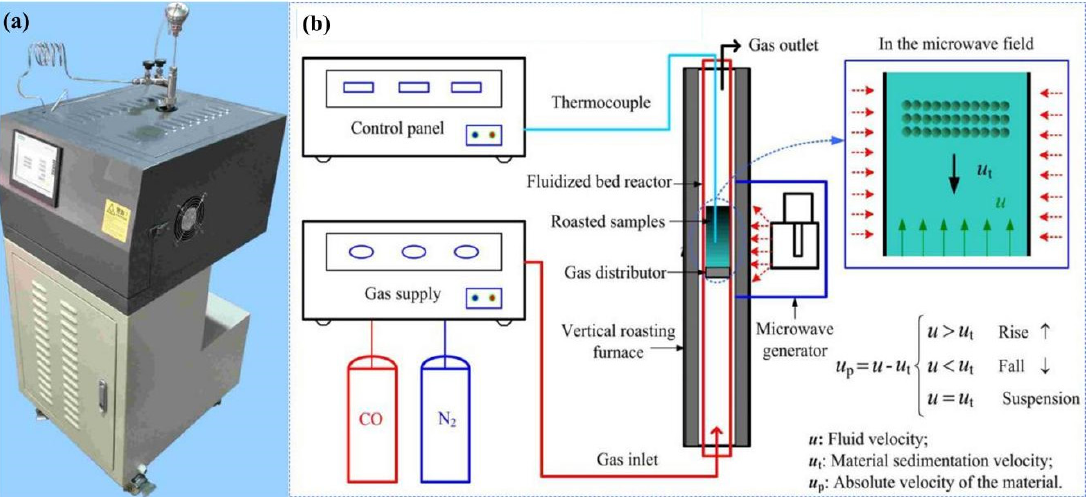
Figure 3. Schematic diagram of the microwave fluidization roasting system: ( a ) Diagram of the equipment, ( b ) schematic diagram of the microwave fluidization roasting system.